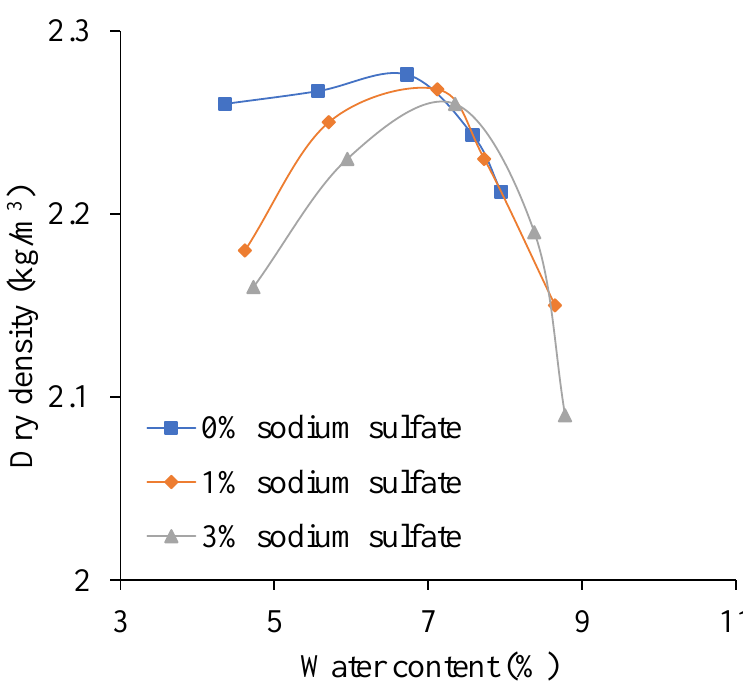
Figure 11. The relationship curves between water content and dry density.